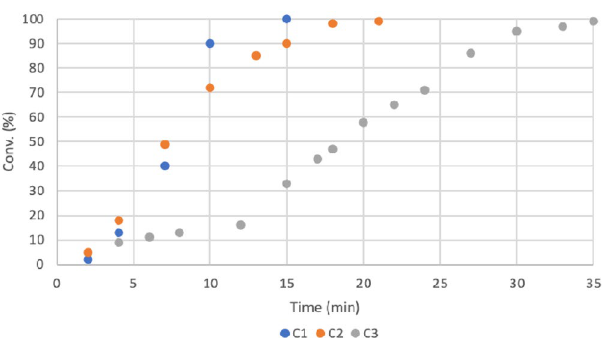
Figure 3. Formation of 4a for cycles C1 to C3 for the Cu-AmP-CPG 1 -catalyzed 1,3-dipolar cycloaddition between benzyl azide 2a and propargyl alcohol 3a . C1 = cycle 1, C2 = cycle 2 and C3 = cycle